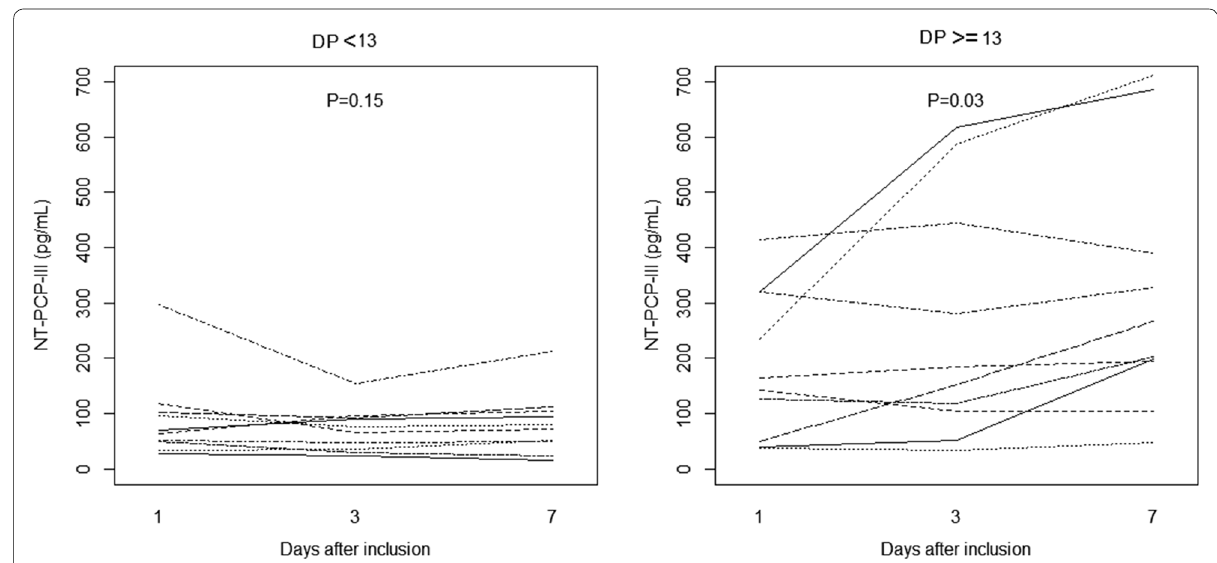
Fig. 5 Changes in serum level of N-terminal peptide for type III procollagen over time in patients ventilated with driving pressure < 13 cmH 2 O 24 h after inclusion ( N 9) and patients ventilated with driving pressure = 1 day 1 after inclusion, 3 day 3 after inclusion, 7 = =